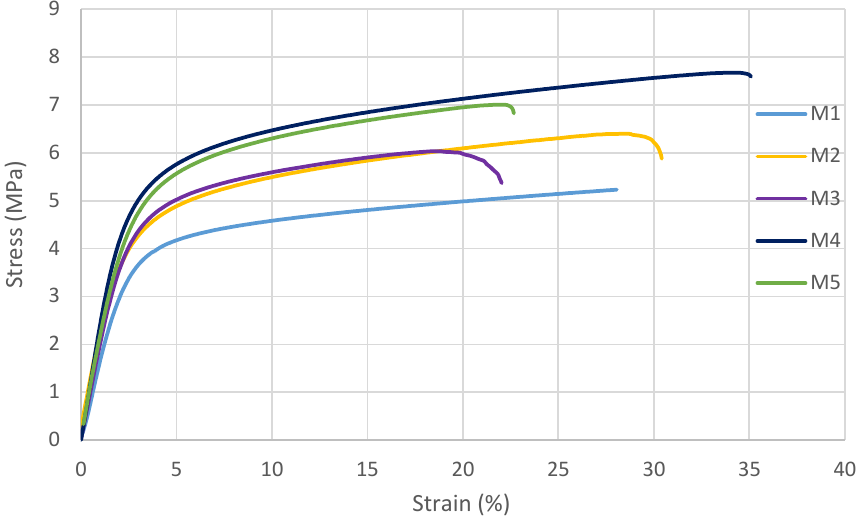
Figure 12. Stress-strain curves for the cast membranes. In terms of mechanical properties, the highest elastic modulus (the slope of the linear elastic region in the stress-strain curve) and yield stress (onset point of yielding) are achieved for the PSF membrane incorporated with 0.3 wt.% CNF, as shown in Figure 13. The elastic modulus increased by 34%, from 175.05 MPa for the pure PSF membrane to 234.5 MPa for the PSF membrane reinforced with 0.3 wt.% CNF. Similarly, the yield stress increased by 32%, from 3.81 MPa for the pure PSF membrane to 5.03 MPa for the PSF membrane reinforced with 0.3 wt.% CNF. Both the elastic modulus and yield stress slightly decrease with the addition of 0.5 wt.% CNF into the PSF matrix. As mentioned earlier, this can be explained by the higher membrane porosity and a higher tendency for agglomeration at a high-nanofiber loading.